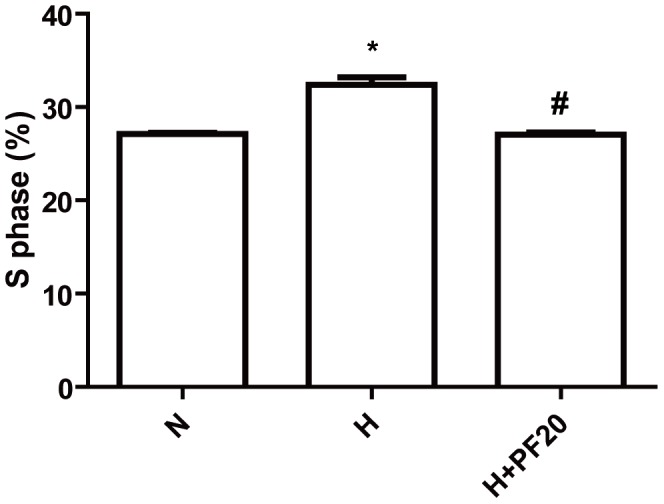
Paeoniflorin decreased the proportion of S phase in hypoxic PASMCs. PASMCs were incubated under normoxic (N), hypoxic (H) condition, or pretreated with PF (20 μmol/l) when under hypoxic condition. * P<0.05 vs. the N group; # P<0.05 vs. the H group; n = 3.